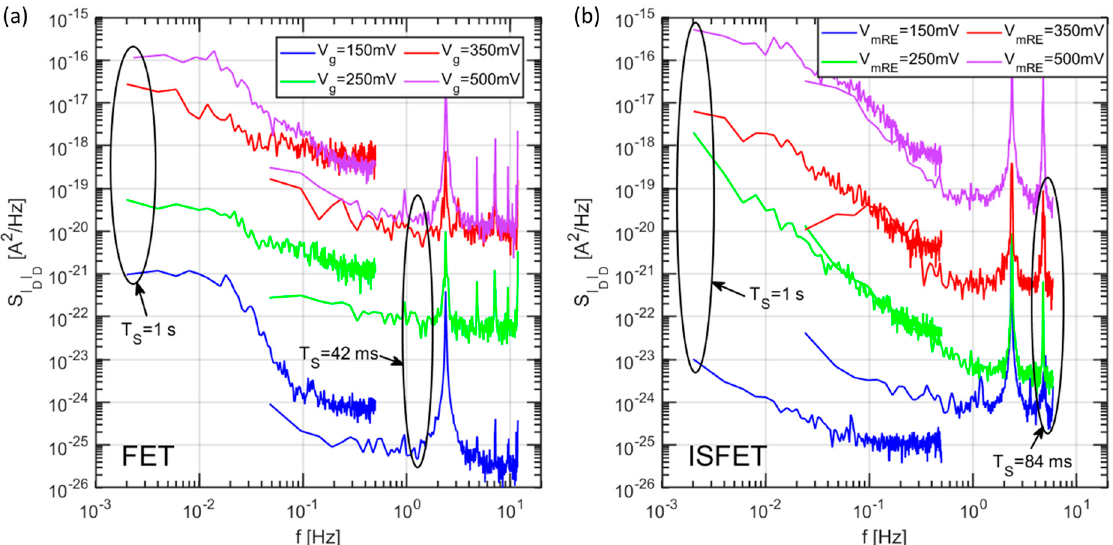
Figure 11. Drain current PSDs extracted at different gate biases for the FET ( a ) and ISFET ( b ), configuration of the same device. Different sampling rates are shown for each bias. The buffer used for the liquid gate of the ISFET configuration has pH = 7.